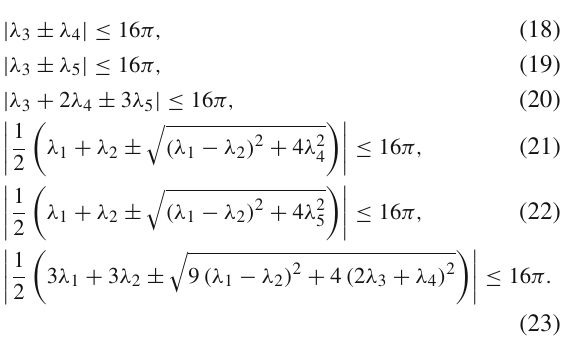
values of m H ± . For instance, for m H ± = 1000 GeV and c β − α = 0 . 25 (lower left plot) the allowed region shrinks to − 380 GeV < m A − m H ± < 200 GeV. In general,